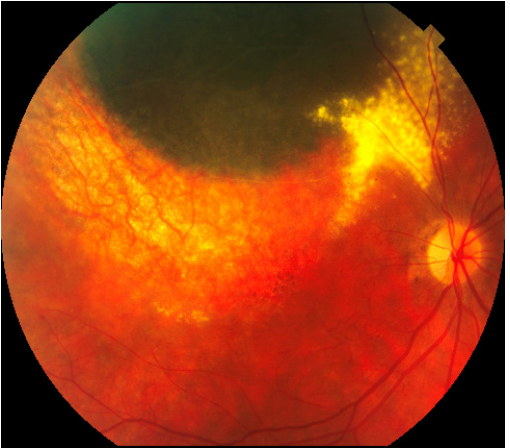
Figure 2. Color fundus photography showing radiation maculopathy in an advanced stage, characterized by chorioretinal and retinal pigment epithelium atrophy in the macular area. J. Clin. Med. 2020 , 9 , x FOR PEER REVIEW